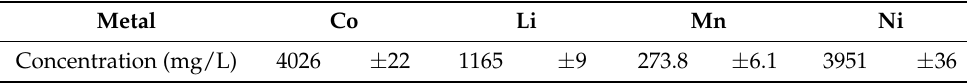
Table 2. Lithium solvent extraction feed stream